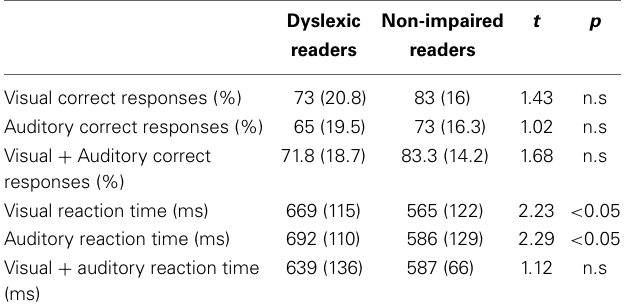
Table 2 | Mean (and Standard Deviation) for the dyslexic and non-impaired readers of the behavioral reading and experimental measures.